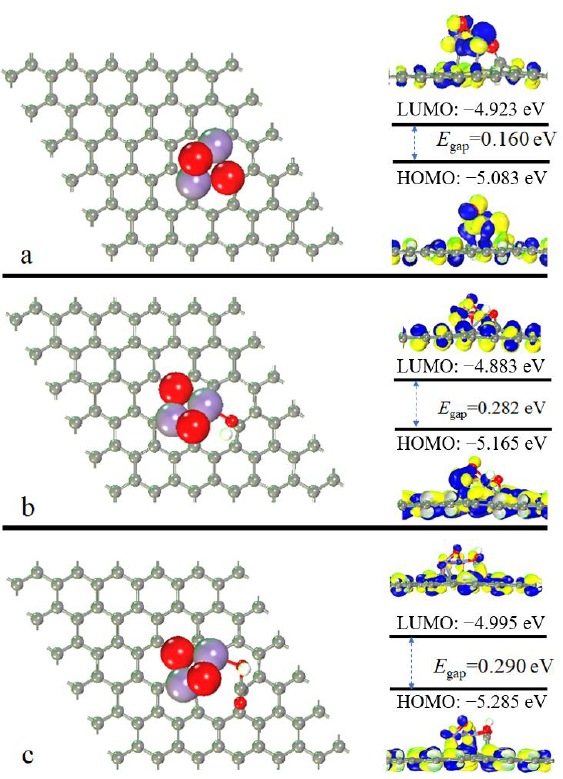
Figure 1. Stable configurations of ( a ) Fe 2 O 3 /G def , ( b ) Fe 2 O 3 /HyG, and ( c ) Fe 2 O 3 /CyG with HOMO and LUMO. The C atom is gray, the O atom is red, the Fe atom is purple, and the H atom is white. The stability of Fe 2 O 3 on G def , HyG, and CyG is evaluated by calculating the adsorp- tion energy ( E ads ) with Equation (13). Accordingly, the E ads for Fe 2 O 3 /G def , Fe 2 O 3 /HyG, and Fe 2 O 3 /CyG are − 1.81 eV, − 7.71 eV, and − 9.61 eV, respectively. The results show